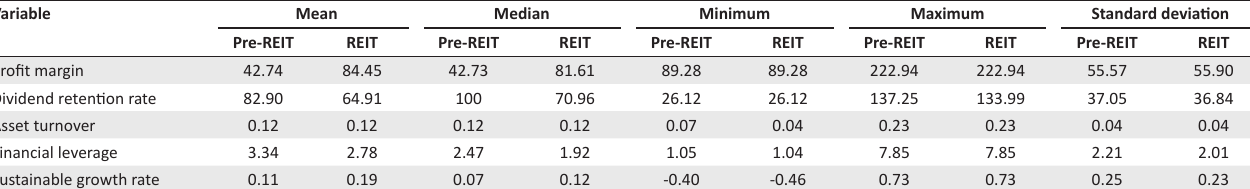
TABLE 2: Descriptive statistics for the pre-real estate investment trust and real estate investment trust periods. Variable